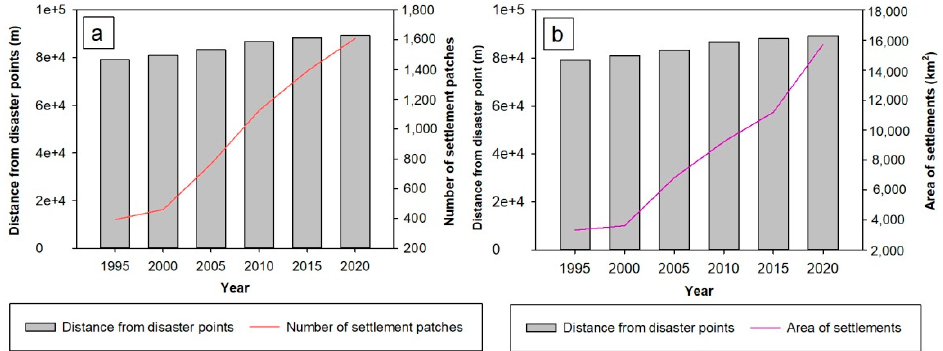
Figure 13. Mountain-hazard distribution and calculation of Euclidean distance around them.